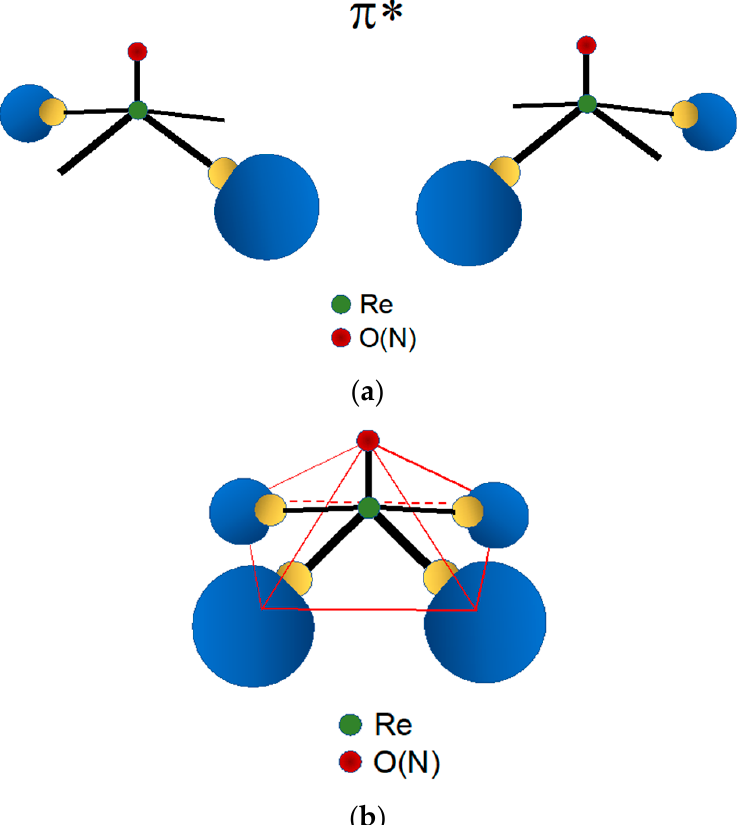
Figure 4. ( a ) Qualitative probability density distribution of the two empties, isoenergetic π * frontier orbitals (FOs) of the Re(X) (X = O, N) functional group in sp symmetry. ( b ) Arrangement of the two FOs in a square pyramidal geometry. The highest density is distributed along the lines connecting the central metal to the coordinating atoms located on the four positions on the basal square plane. It is important to note that in the figure the lobes of the MOs were arbitrarily displaced along the bond axis and not centred on the metal atom. This unconventional representation was preferred to highlight how the spatial arrangement of the electronic density nicely accounts for the square pyramidal geometry of the resulting